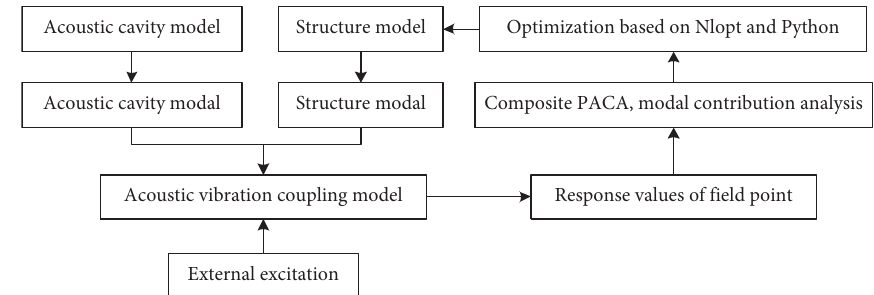
Figure 1: The process of composite panel acoustic and modal contribution